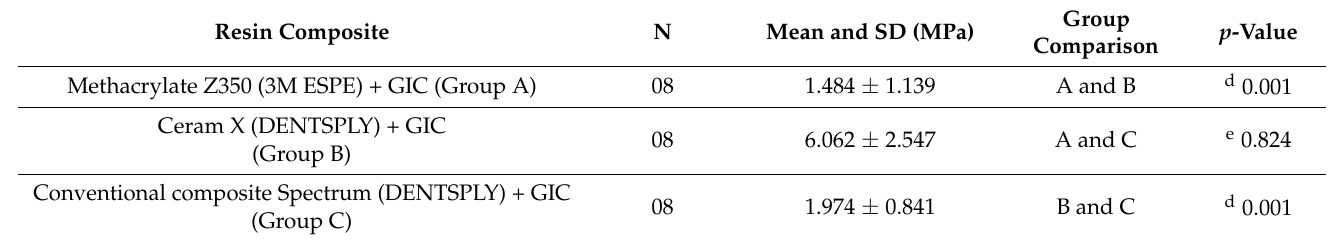
Table 5. Shear bond strength values of resin composite and conventional glass ionomer